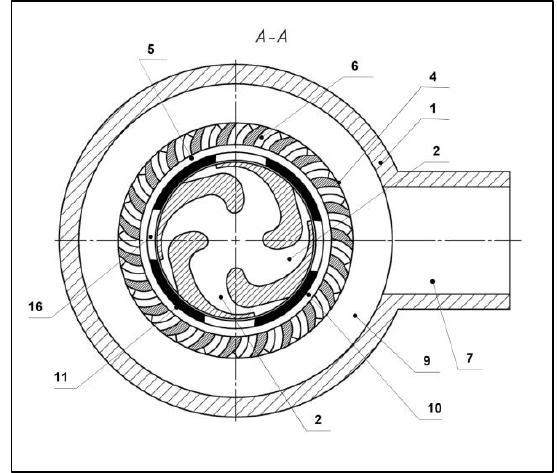
Figure 5. Schematic of the mesh turbine, A−A cross-section with the closed nozzle.